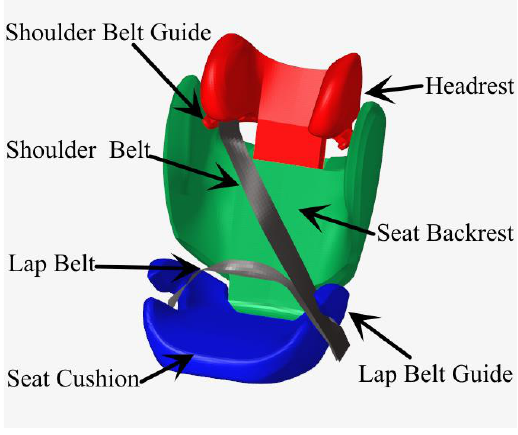
Figure 6. Layout of a Child Restraint System.